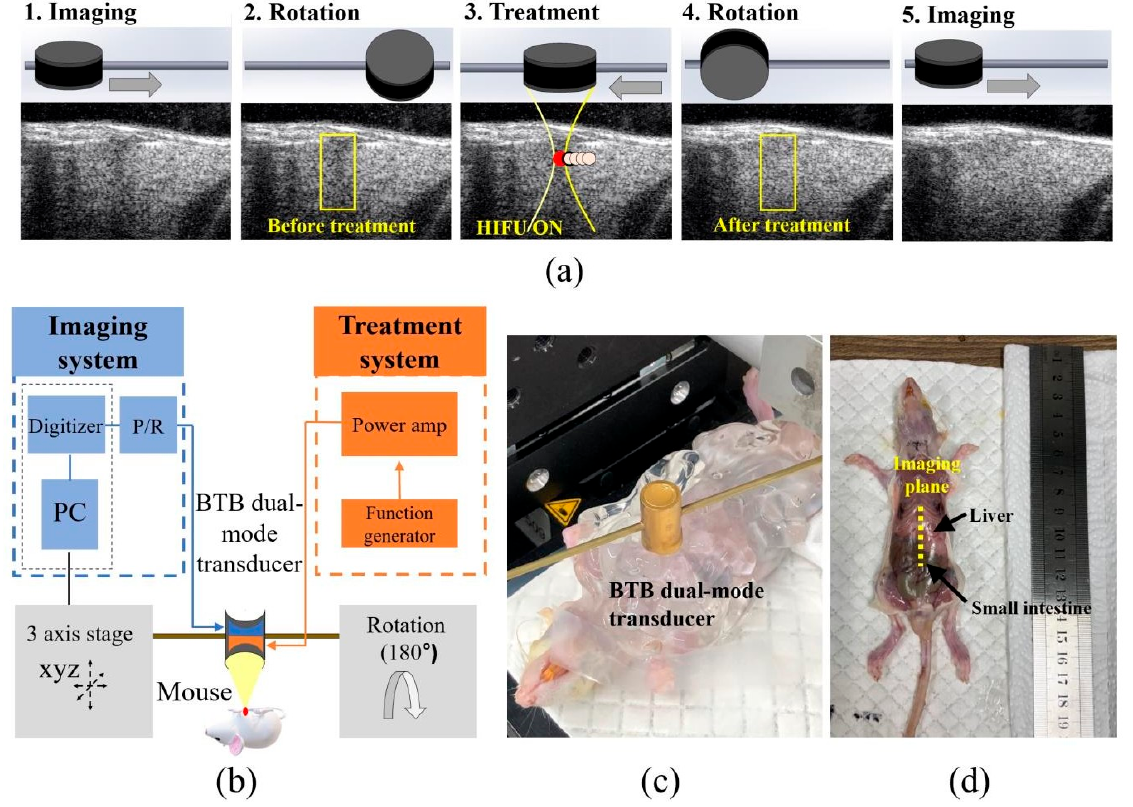
Figure 7. Ultrasound imaging and treatment using the BTB transducer. ( a ) Schematic illustration of the procedure used for the in vivo experiments: 1. imaging; 2. rotation; 3. treatment; 4. rotation; and 5. imaging; ( b ) the dual-mode system and its components; ( c ) a photograph taken during an in vivo experiment; and ( d ) mouse dissection after treatment.